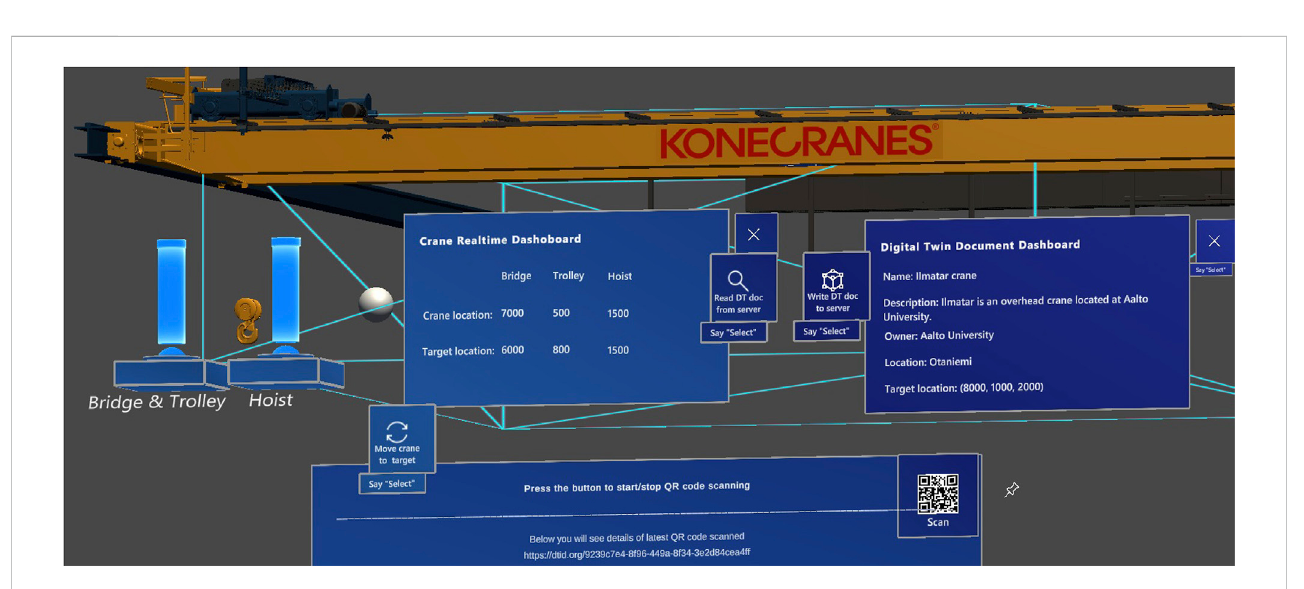
FIGURE 5 Screenshot of the implemented MR application “ HoloCrane ” (Unity developer view on